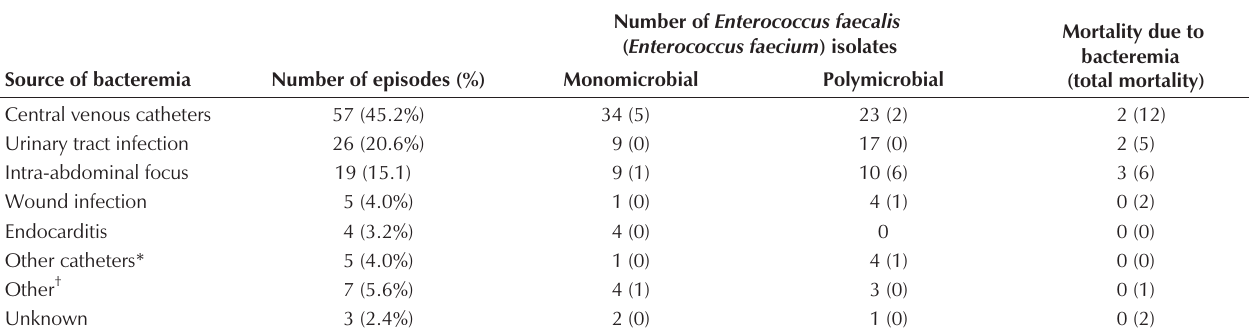
Number of enterococcal isolates, and total and bacteremia-related mortality by source of infection in 126 episodes of enterococcal bacteremia